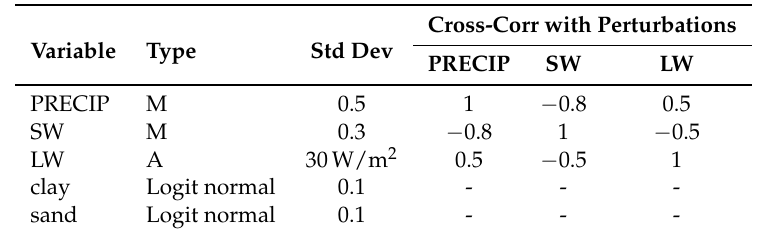
Table 1. Perturbation parameters for the atmospheric variables precipitation (PRECIP), shortwave (SW) and longwave (LW) downward radiation and the model parameters (clay and sand fractions). The perturbations are multiplicative (M), additive (A) and Logit-normal. The cross-correlation between the variables are given in the Cross-corr